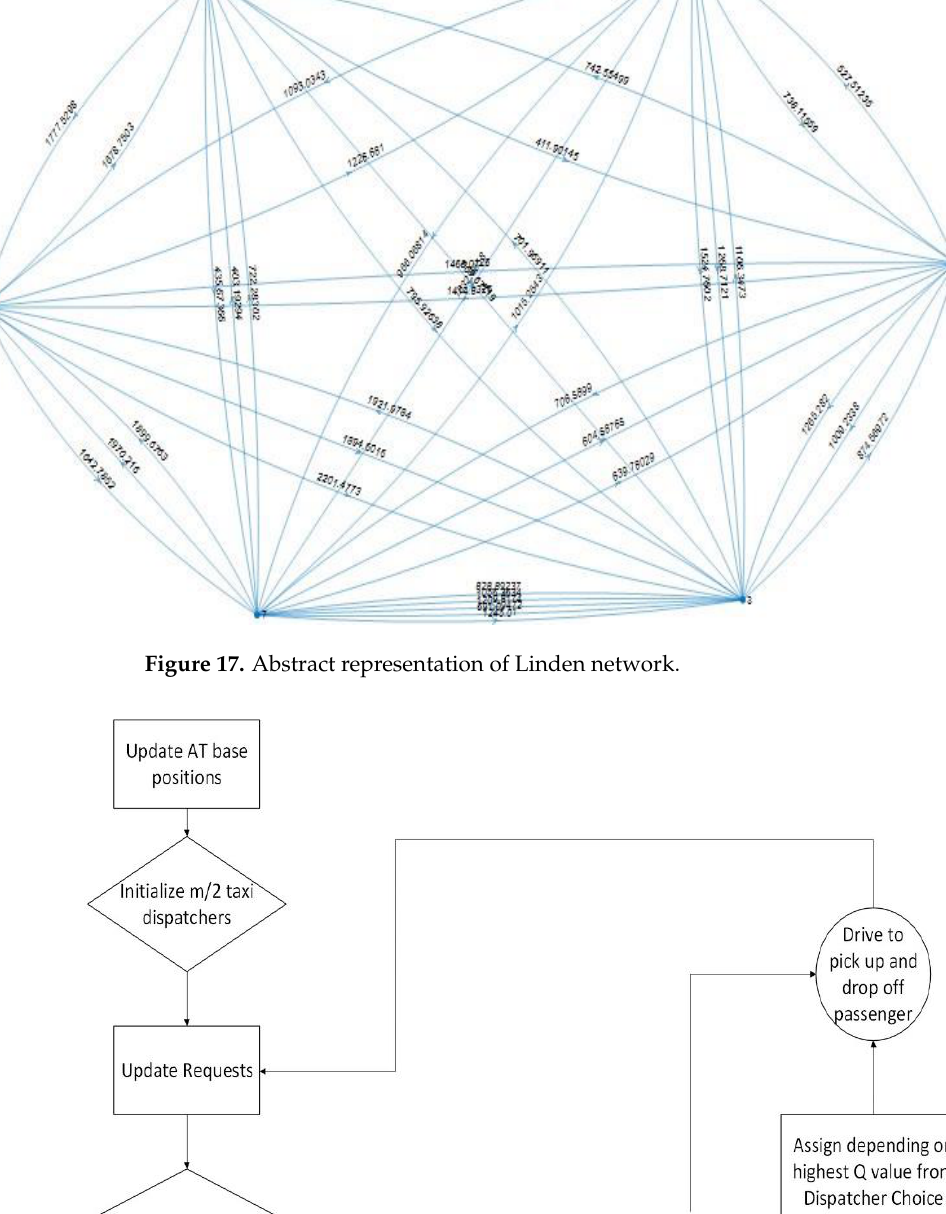
Sensors 2022 , 22 , 8317